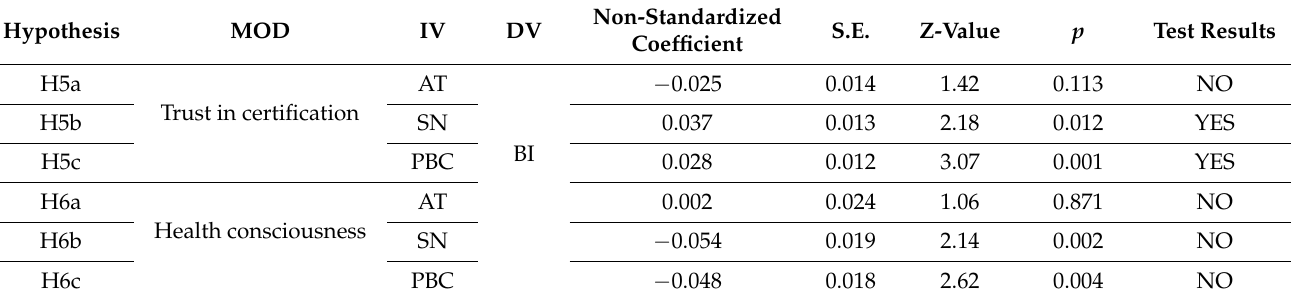
Table 4. Moderating